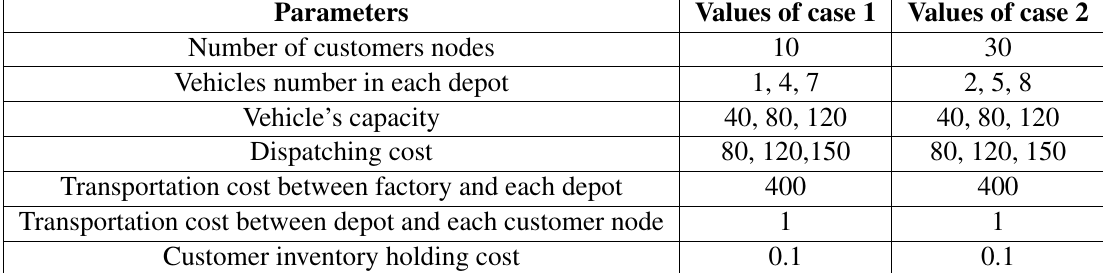
Table 1 The parameters value setting in the numerical simulation.